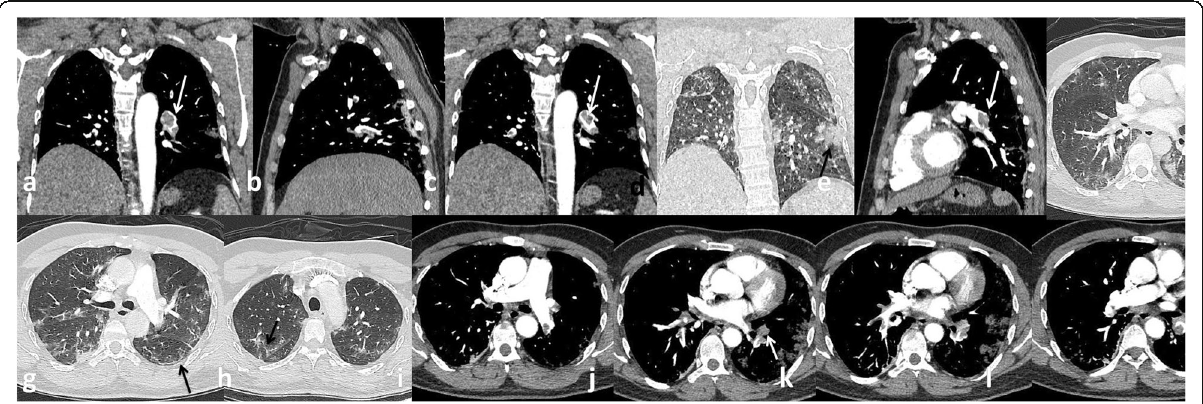
Fig. 6 Male patient 43 years old with pulmonary emoblism at left main pulmonary artery (white arrows in a , c , e ), subsegmental artery (white arrow in j ), area of pulmonary infarction (black arrow in d ), COVID-19 infection manifestations (black arrows in f , g , h